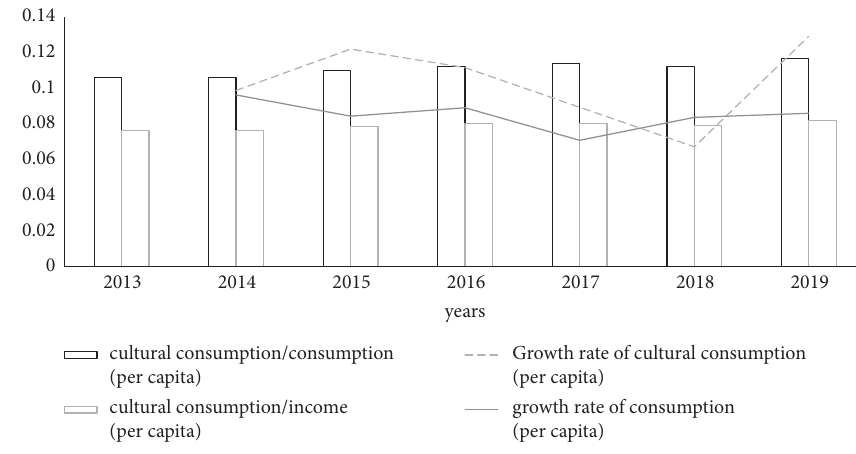
Figure 1: Growth of cultural consumption